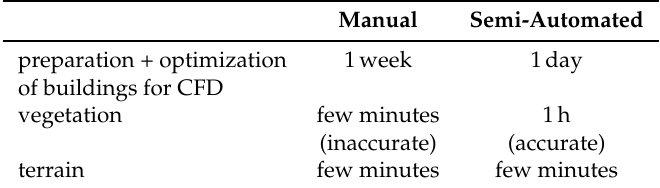
Table 3. Comparison of manual and semi-automated workflow for the case study with 75 buildings. Manual Semi-Automated preparation + optimization 1week of buildings for